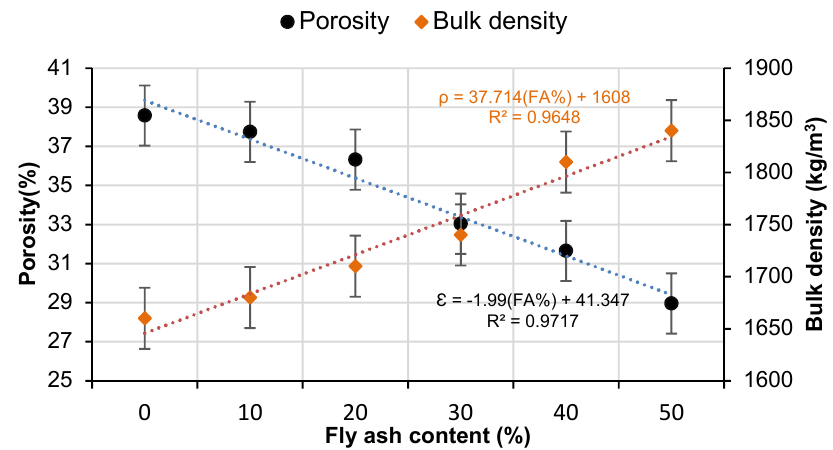
Figure 4. Porosity and bulk density of CEBs as a function of fly ash content. Figure 7. Porosity and bulk density of CEBs as a function of fly ash content.